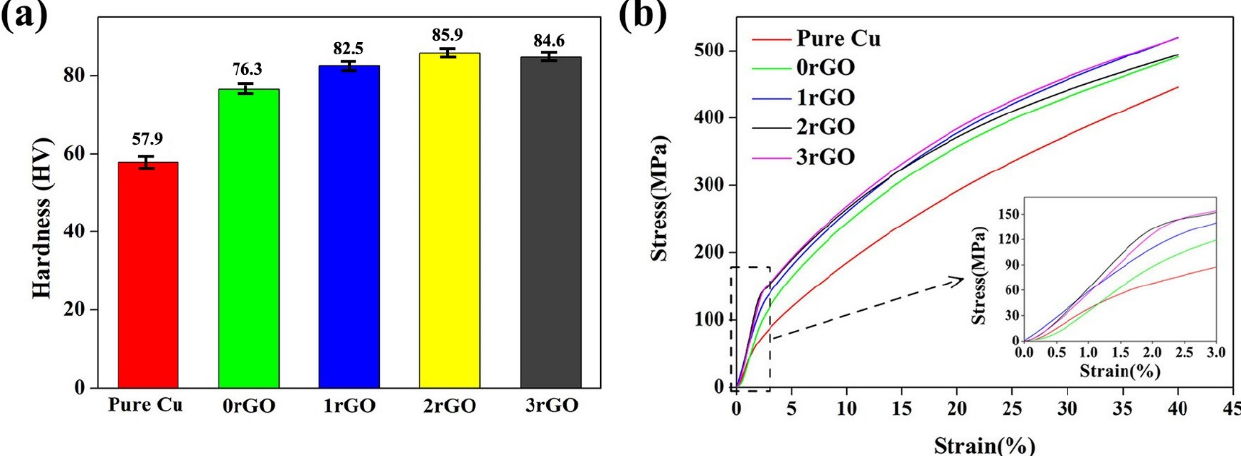
Figure 10. Hardness ( a ) and room-temperature compressive stress-strain curves ( b ) of the sintered pure copper and bulk compacts.